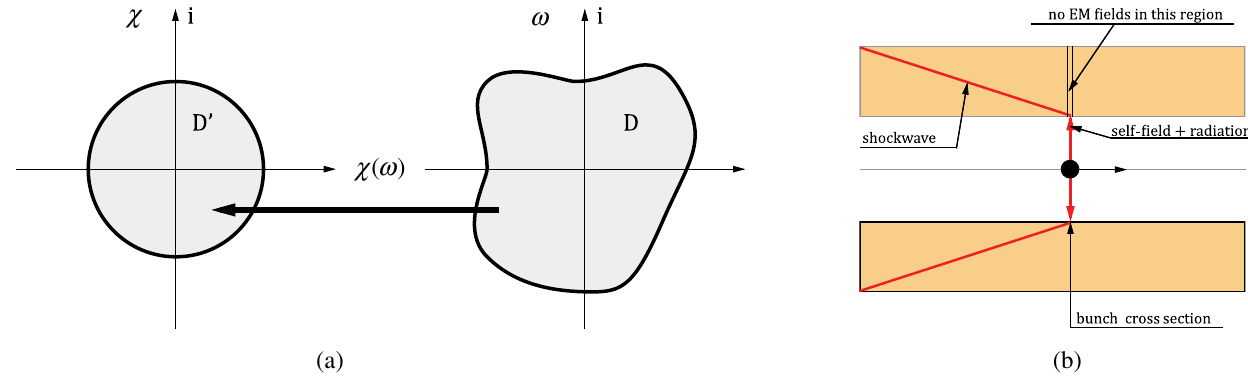
FIG. 1. (a) Definition of the conformal map from the ω plane to the χ plane. (b) Schematic of the shock wave formation